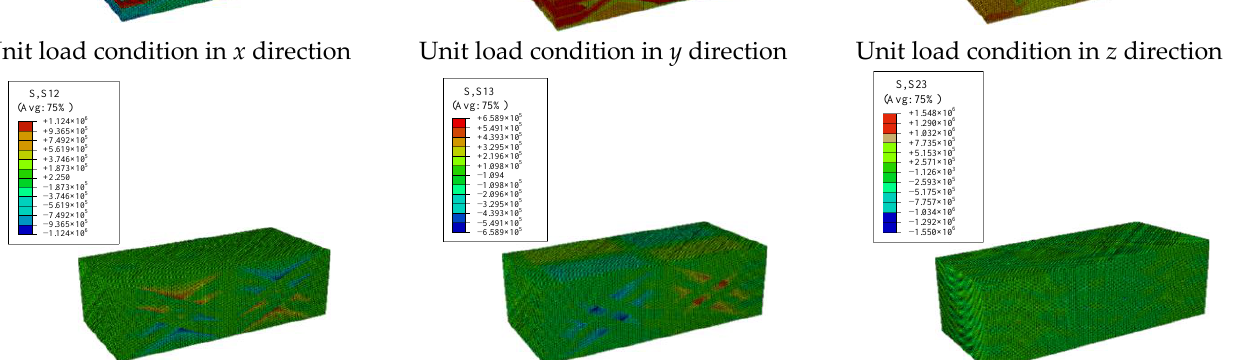
Table 10. The equivalent thermoelastic parameters.